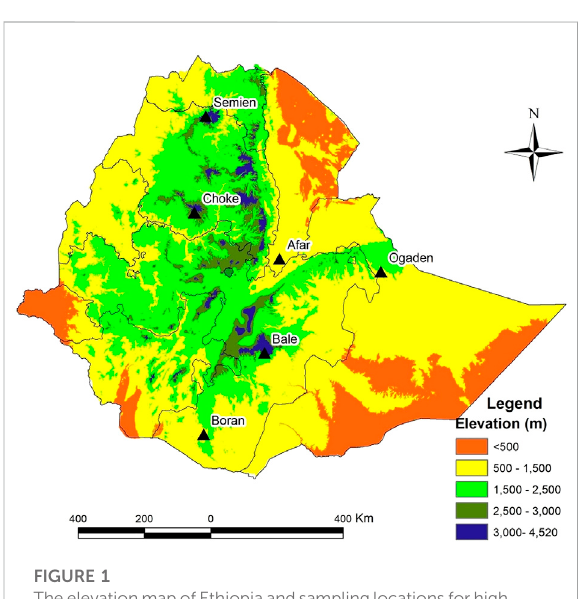
FIGURE 1 TheelevationmapofEthiopiaandsamplinglocationsforhigh and low-altitude cattle